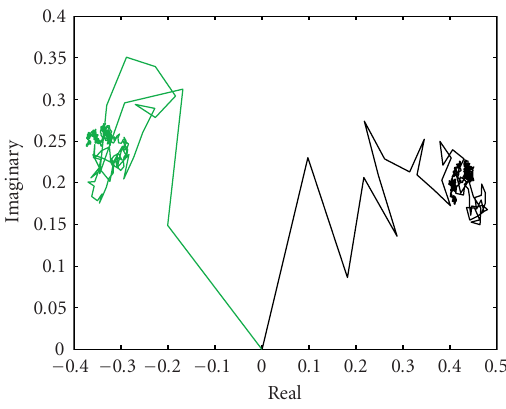
Figure 4.1. Random walks associated with parameter sequences of the form ( a n ) = (exp( i θ n )) for π ]. The dark and light lines correspond to the θ n a random variable uniformly distributed on [0,2 random walks determined by the respective partial sums Σ n and Σ (cid:11) n defined in (4.72). The figure—an illustration of the convergence of the partial sums proven in Proposition 4.8—shows the location of the partial sum at step n in the complex plane with lines connecting successive steps. The di ff erence equation dynamics of the iterates ( v n ) defined by (2.1) corresponding to these random walks are depicted in Figure